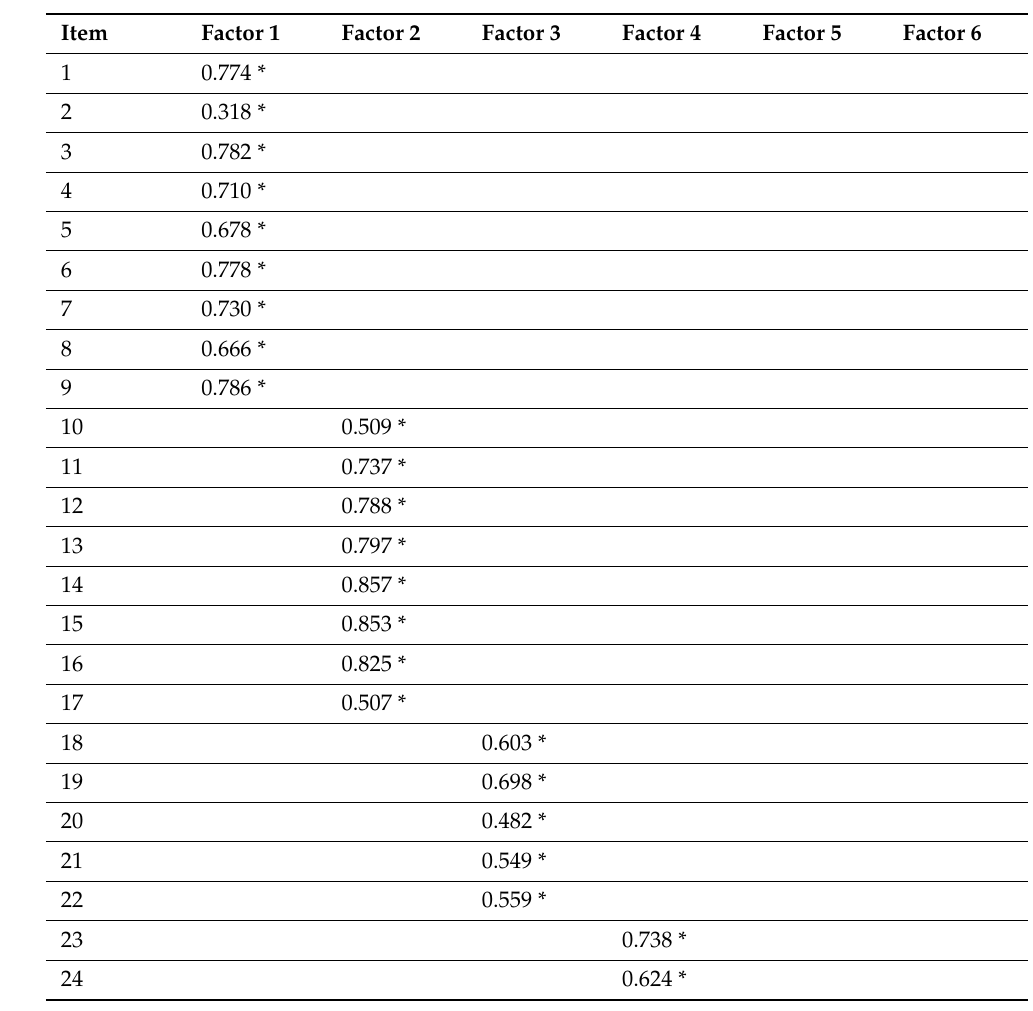
Table 6. Factor loadings derived from the LS (least squared) estimation of the Confirmatory Factor Analysis ( λ